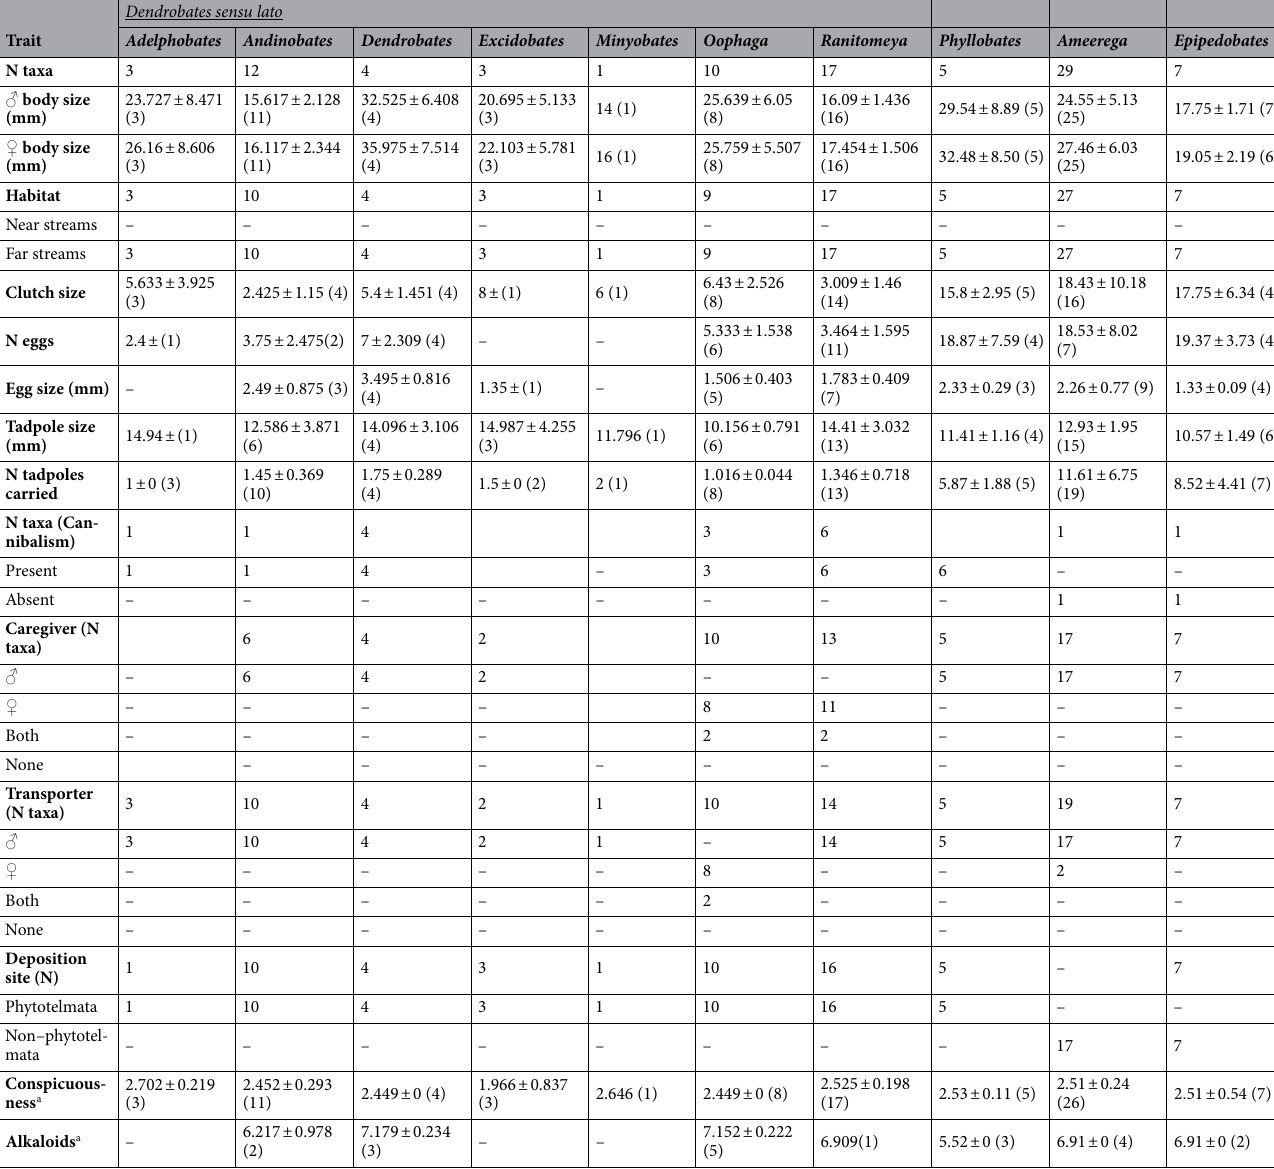
Table 1. Parental care traits in dendrobatid species considered to be aposematic. The symbol “–” denotes unknown